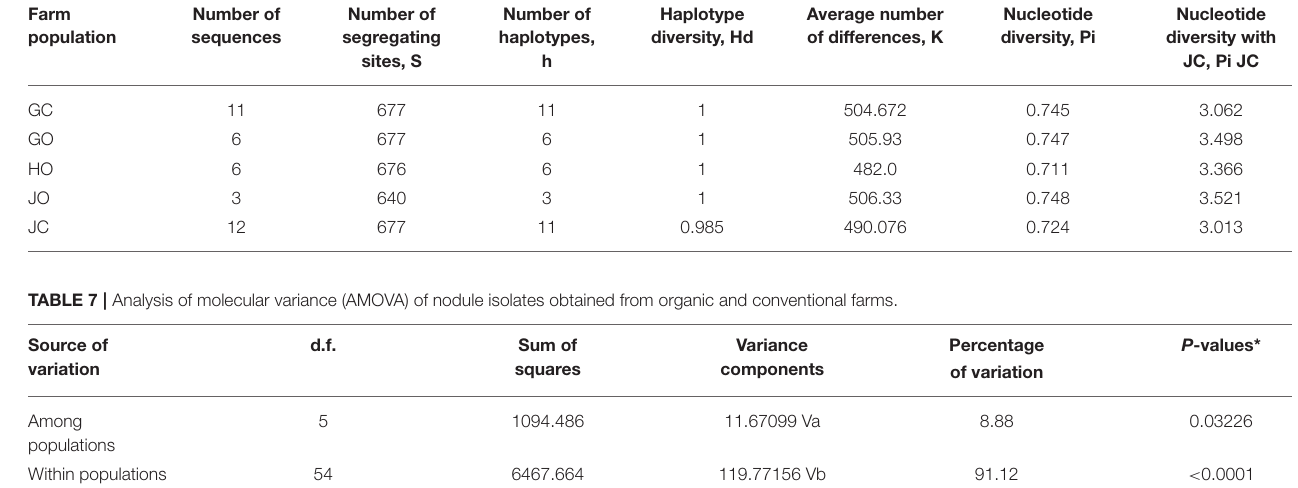
TABLE 6 | Genetic diversity of bradyrhizobia isolates obtained from trapping of soybean in organic and conventional farms. Farm population